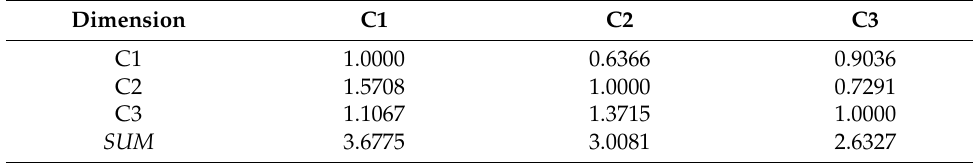
Table 7. The non-fuzzy comparison matrix of SF-AHP. Dimension